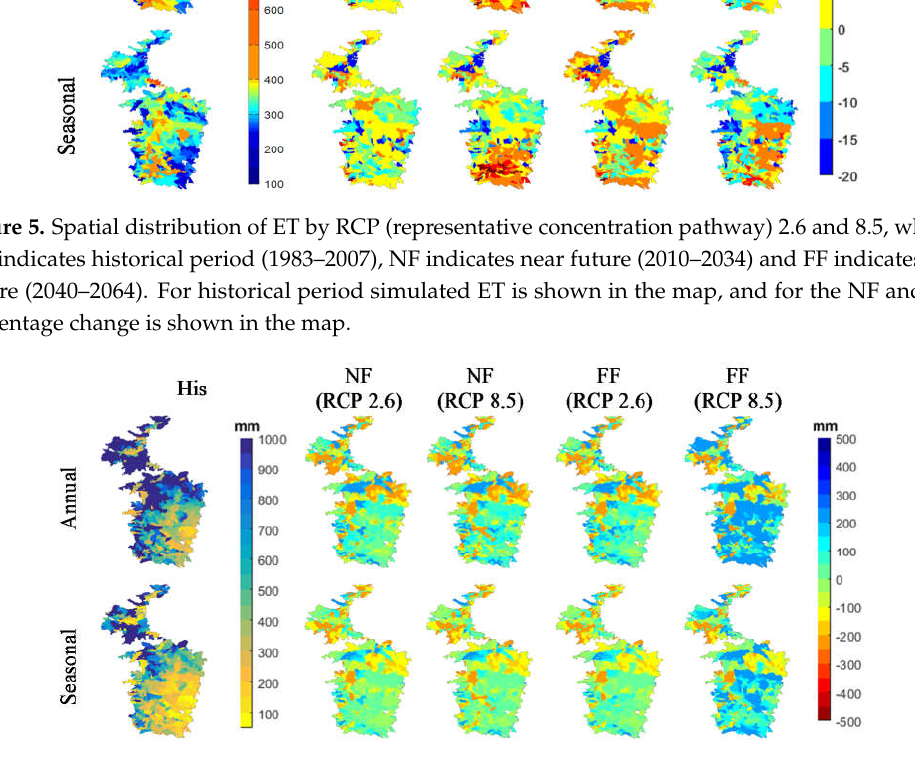
Figure 6. Spatial distribution of soil moisture by RCP 2.6 and 8.5, where His indicates historical period (1983–2007), NF indicates near future (2010–2034) and FF indicates far future (2040–2064). For historical period simulated soil moisture is shown in the map, and for the NF and FF difference of soil moisture is shown in the